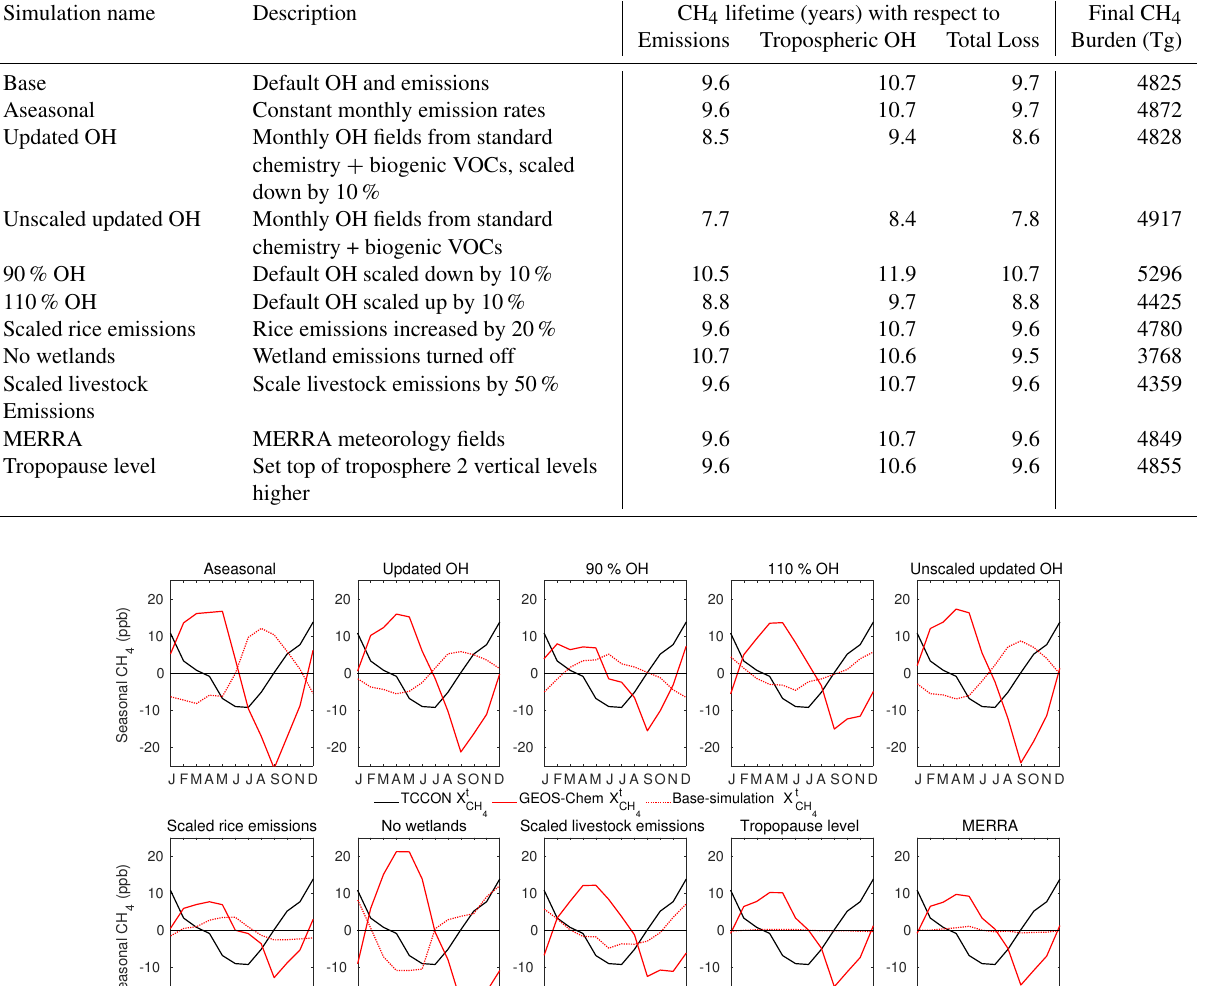
Table B1. List of sensitivity experiments.